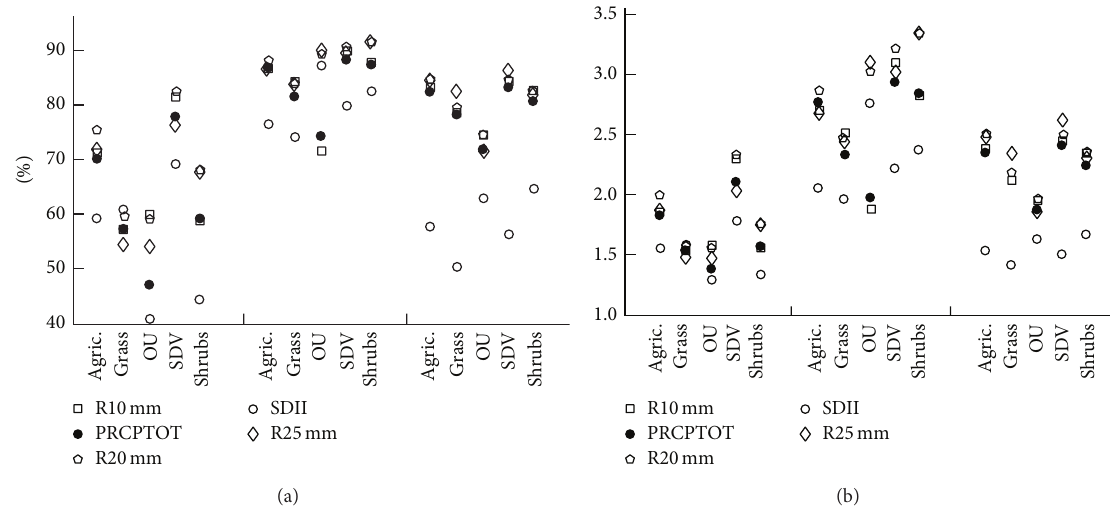
Figure 3: Chebyshev’s theorem (a) and 𝑘 value (unitless (b)) for the significant indices by land use by virtual region. From left to right: north, central, and south regions.